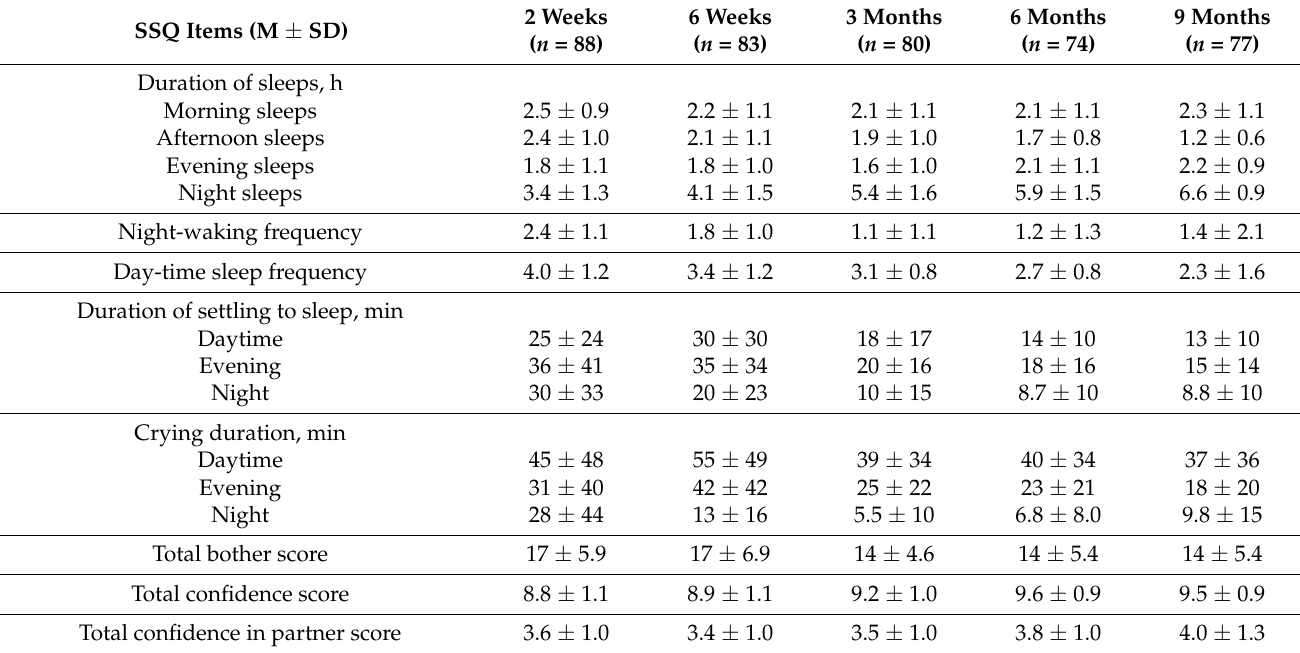
Table 3. Sleep and Settle Questionnaire (SSQ) outcomes across the first nine